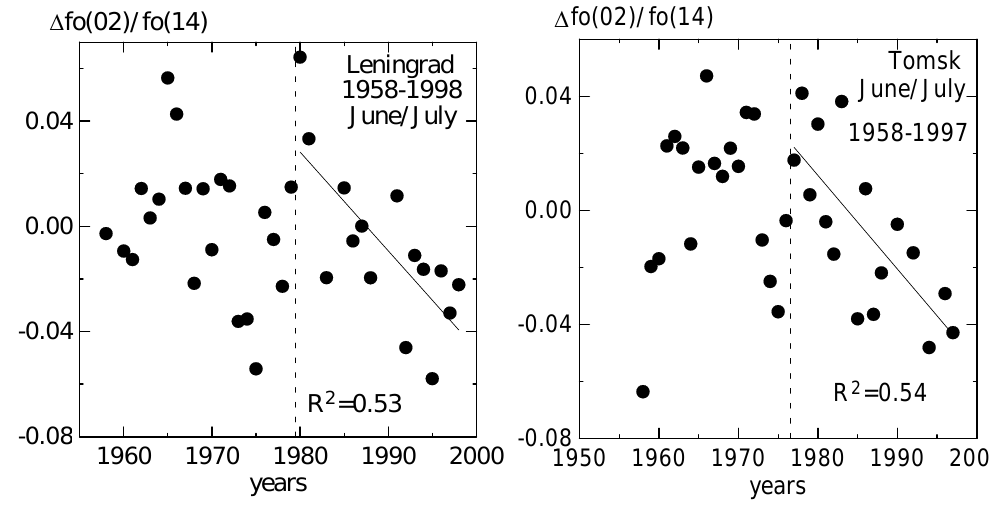
Fig. 13. Time behavior of 1 fo (02)/ fo (14) for Leningrad and